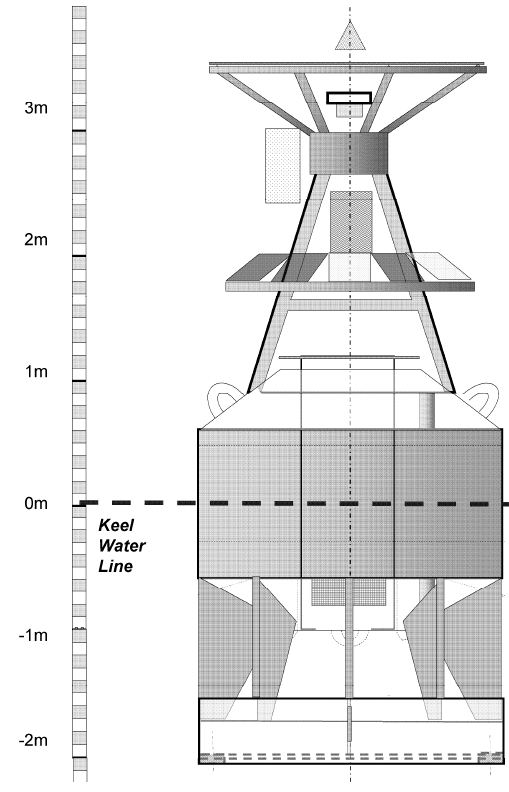
Figure 2a: Schematic layout of the GITEWS buoy. The construction was designed and 2 Fig. 2a. Schematic layout of the GITEWS buoy. The construction calculated by Dirk Berger, Altefähr/Germany. 3 was designed and calculated by Dirk Berger, Altef¨ahr/Germany.